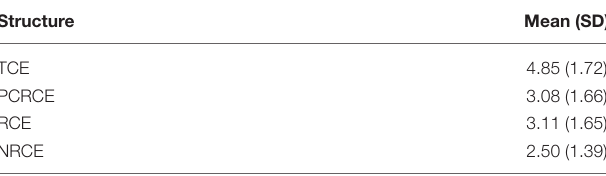
TABLE 1 | Experiment 1 mean sentence ratings and standard deviations. Structure